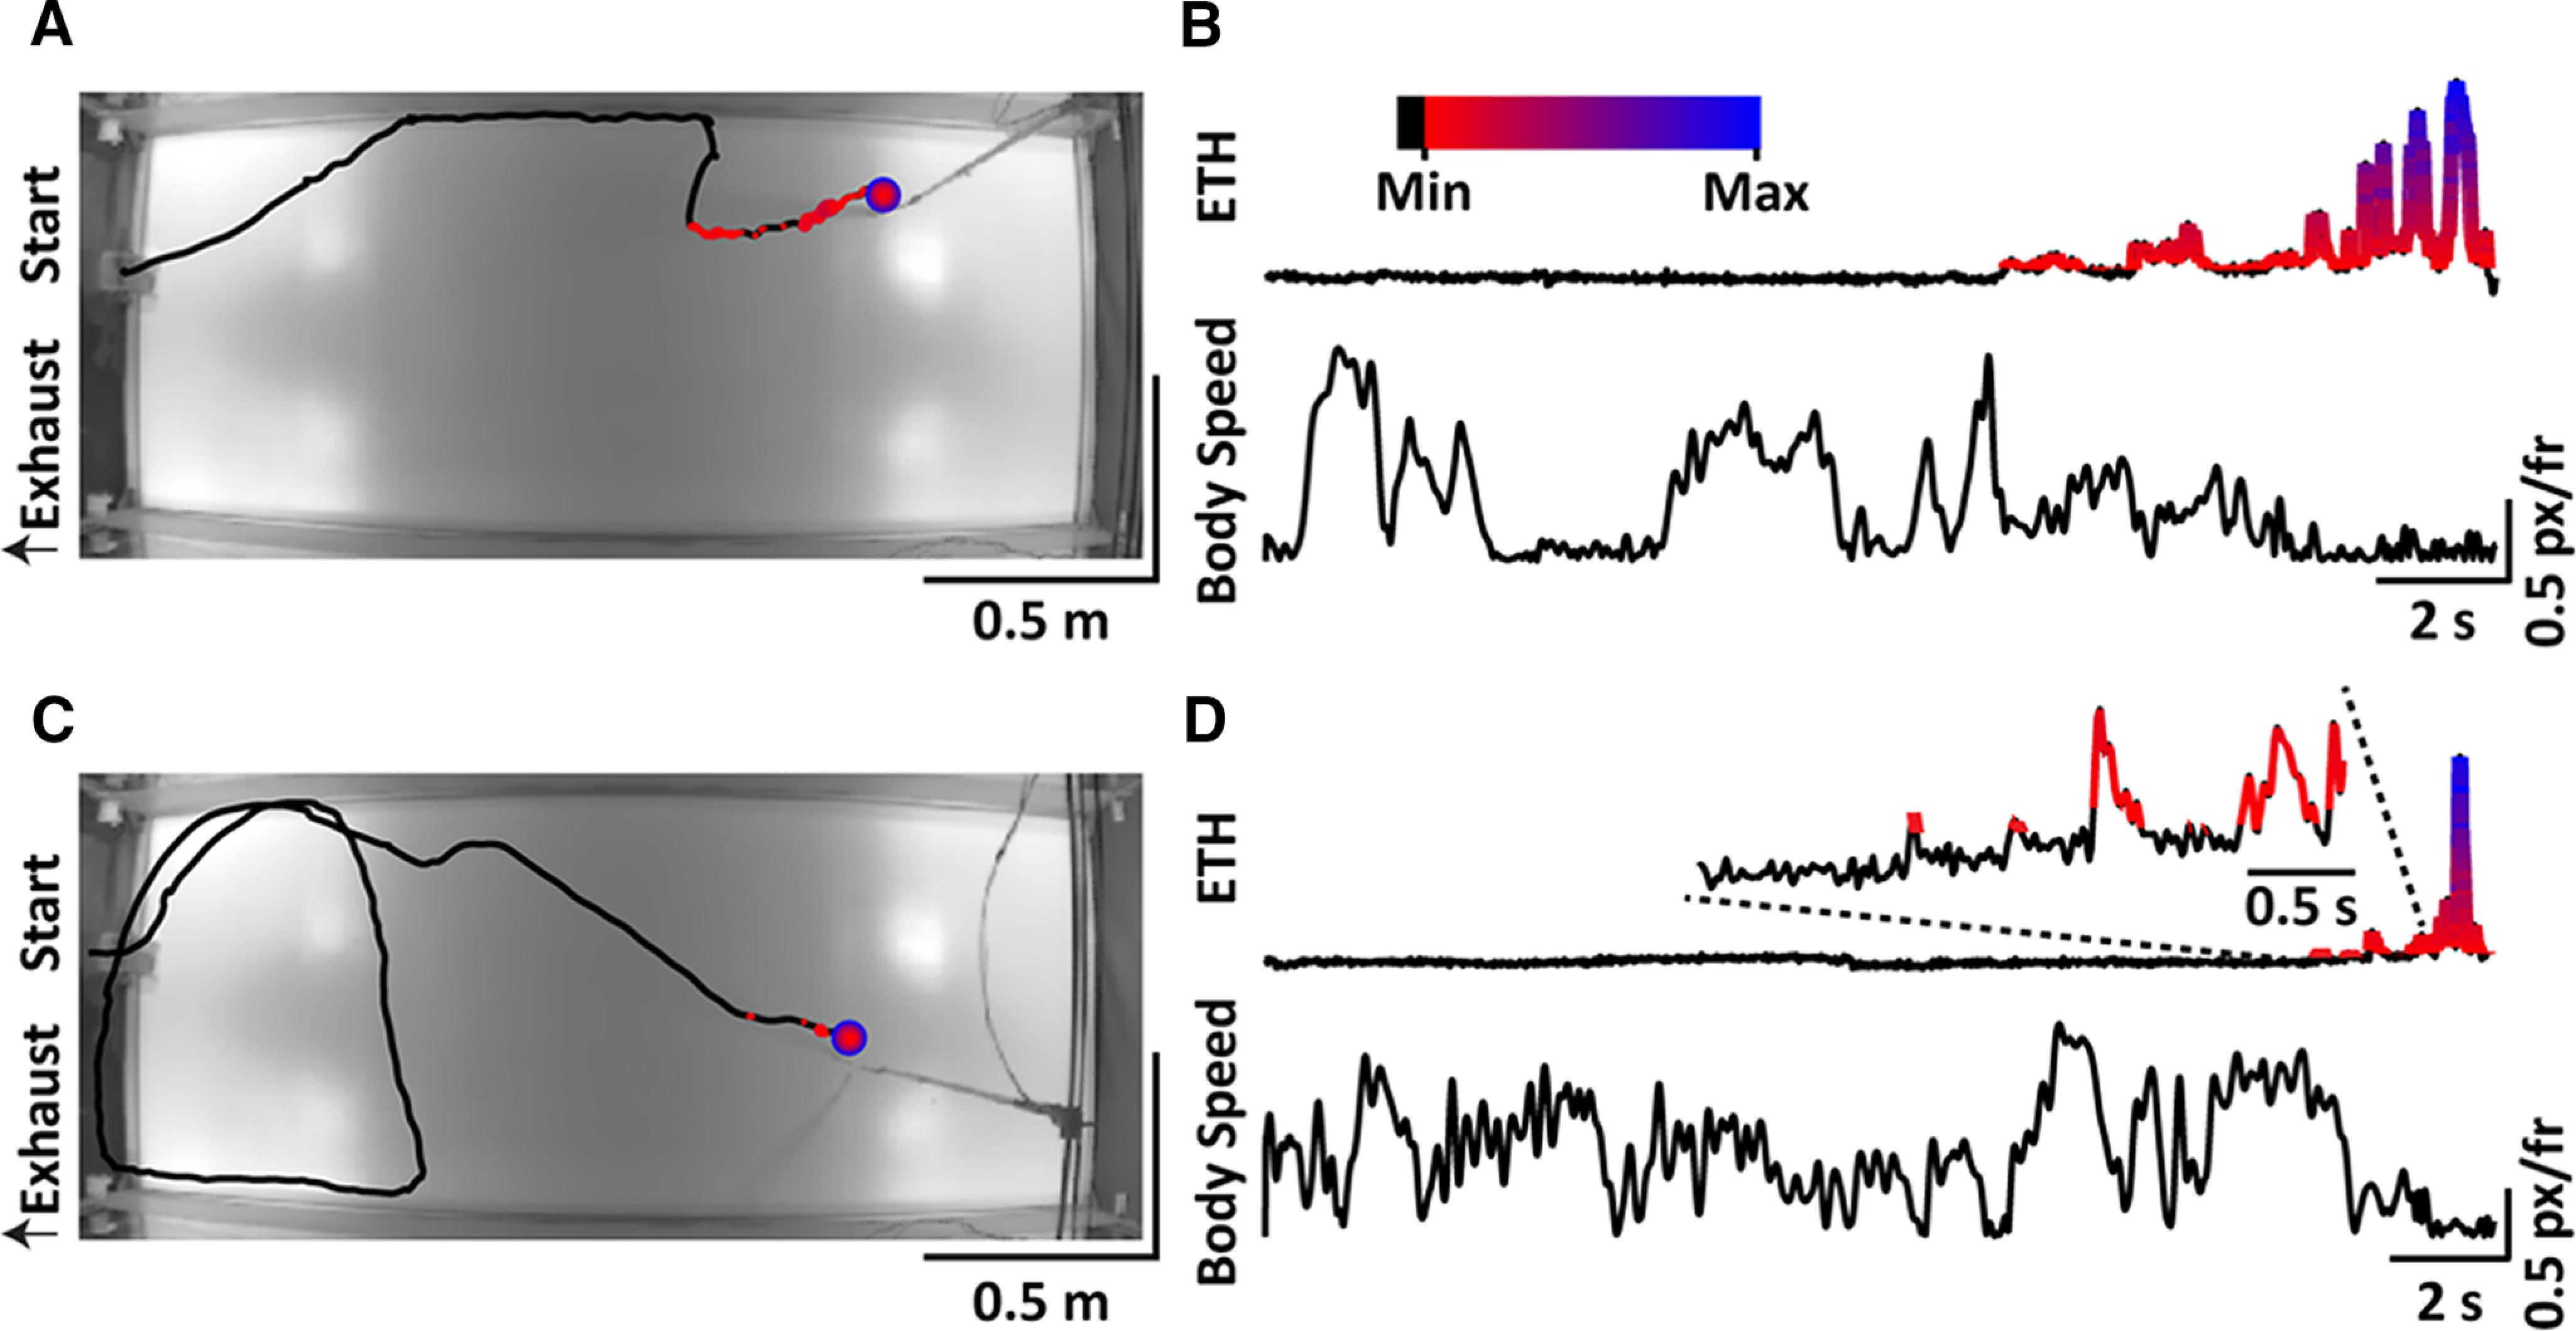
Plume contacts detected by the head-mounted ethanol sensor correlate with behavioral changes in freely behaving rodents. A, An example trajectory of a mouse engaged in odor-guided navigation in our custom-designed arena. Overlaid are the points indicating the locations where plume contacts occurred with the color and size of the points varying by the magnitude of the ethanol plume signal, shown in B, measured by the head-mounted sensor. B, The deconvolved ethanol signal (top), recorded by the head-mounted sensor, with the body speed (bottom) of the animal over the course of a single trial trajectory, shown in A. The plume contacts, set by a threshold, and the magnitude, indicated by the change in color from red (low) to blue (high) are overlaid on the deconvolved ethanol signal. The plume contact is shown to reduce the body speed of the animal. In addition, the plume contact can also be seen to cause a change in the orientation of the animal apparent in A. C, D, Same as A, B but from another trial where the location of the ethanol source is changed. Inset in the top panel of D shows the zoomed-in view of the deconvolved ethanol signal within the window indicated by the dashed line.